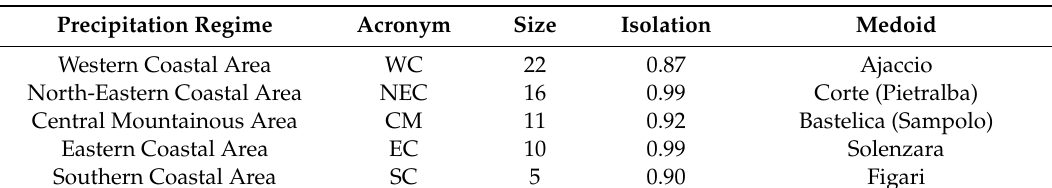
Table 2. Five resulting precipitation regimes from cluster analysis based on k-means, its acronym, size and isolation. The Medoid indicates the representative weather station. Medoids in brackets indicate alternatives when using hourly data.